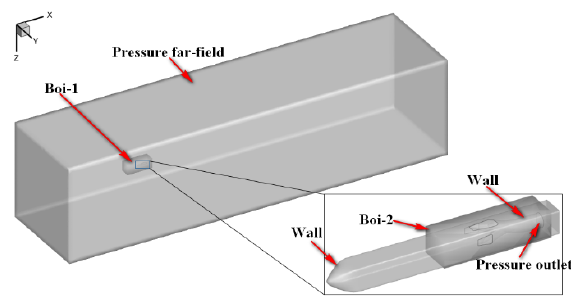
Figure 5. Setting of Steady State Boundary Conditions.